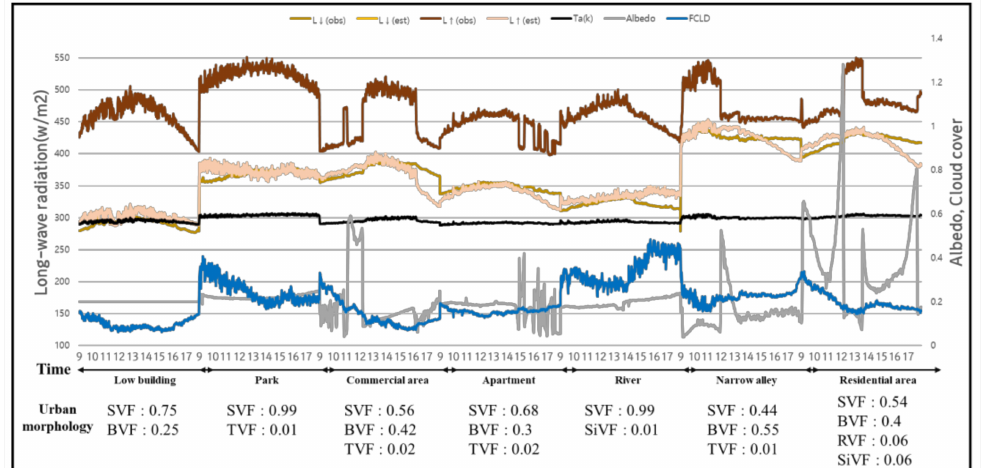
Figure 6. Analysis of incoming longwave radiation by comparison with meteorology data, albedo, and urban morphology from 7 sites. Cloud cover was calculated using air temperature (Ta) and relative humidity